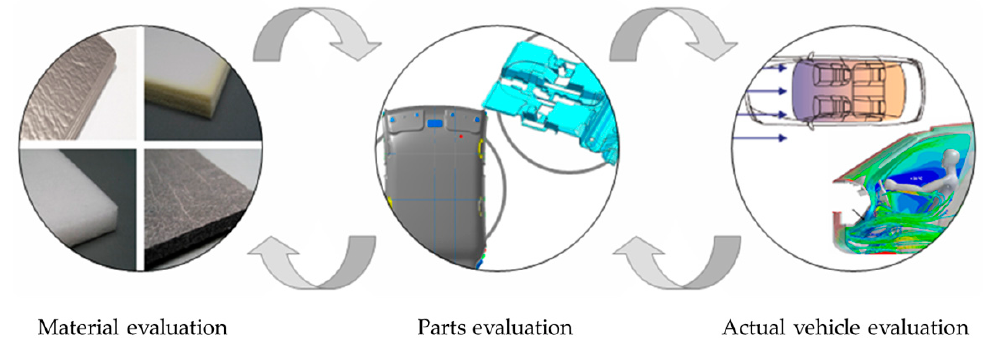
Figure 3. Product development process according to the evaluation method of insulation performance standard of automotive interior parts.